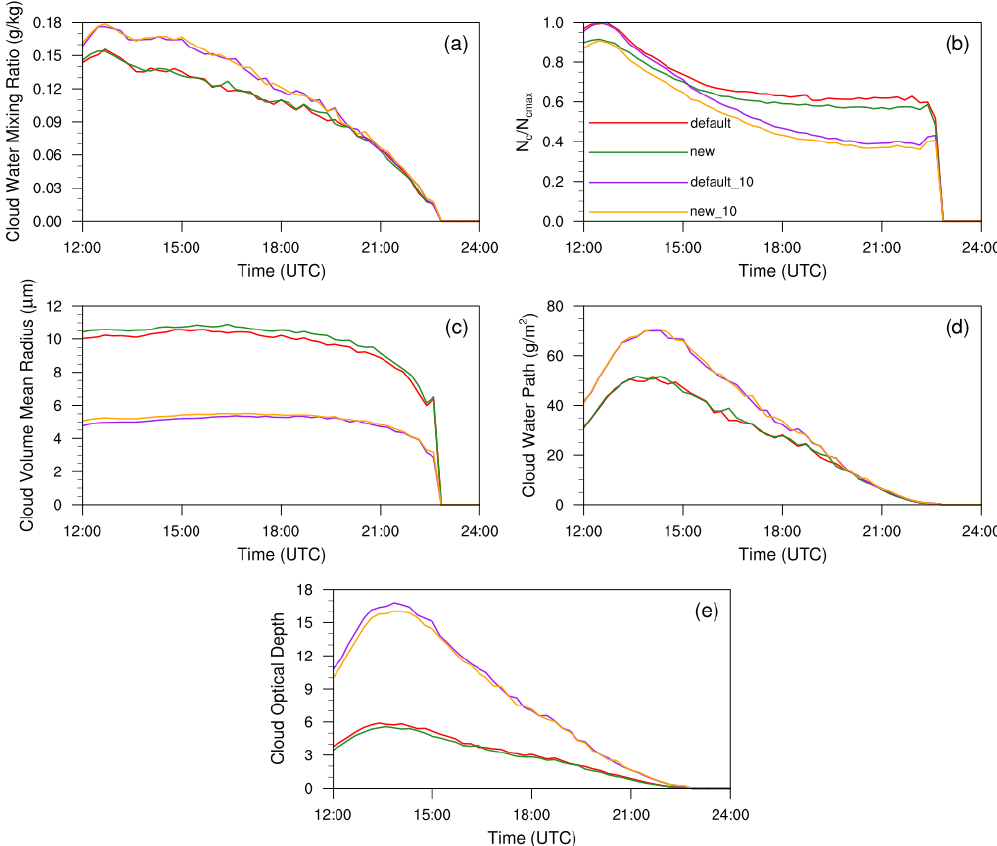
Figure 5. The temporal evolutions of main cloud microphysical and optical properties in all simulation experiments for the stratocumulus case, including (a) cloud water mixing ratio ( q c ) (gkg − 1 ), (b) cloud droplet number concentration ( N c ) (cm − 3 ), (c) cloud droplet volume mean radius ( r v ) (µm), (d) cloud water path (CWP) (gm − 2 ), and (e) cloud optical depth ( τ ). In (b) , N c values in the experiments default and new are normalized by the maximum cloud droplet number concentration ( N cmax ) from default ; N c values in the experiments default_10 and new_10 are normalized by N cmax from default_10 . The four experiments are detailed in Table 1.